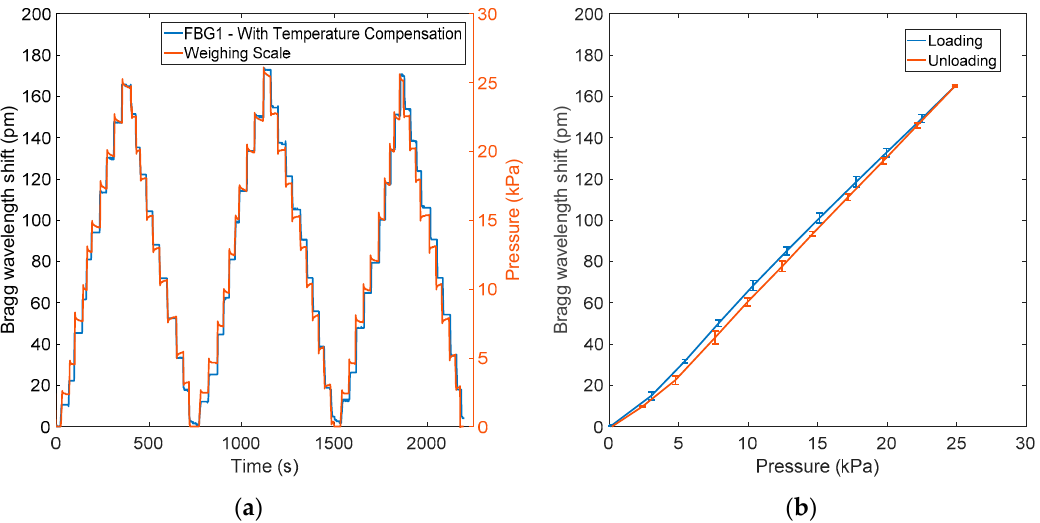
Figure 6. ( a ) Cyclical loading/unloading experiment up to 25 kPa. ( b ) Bragg wavelength shift versus contact pressure from Figure 6a, which demonstrates a linear relationship, repeatable results, and low hysteresis over three cycles.